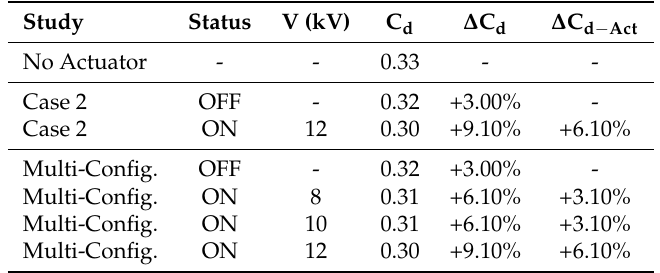
Table 7. Experimental results at Re = 2.25 × 10 5 for slant angle 25 ◦